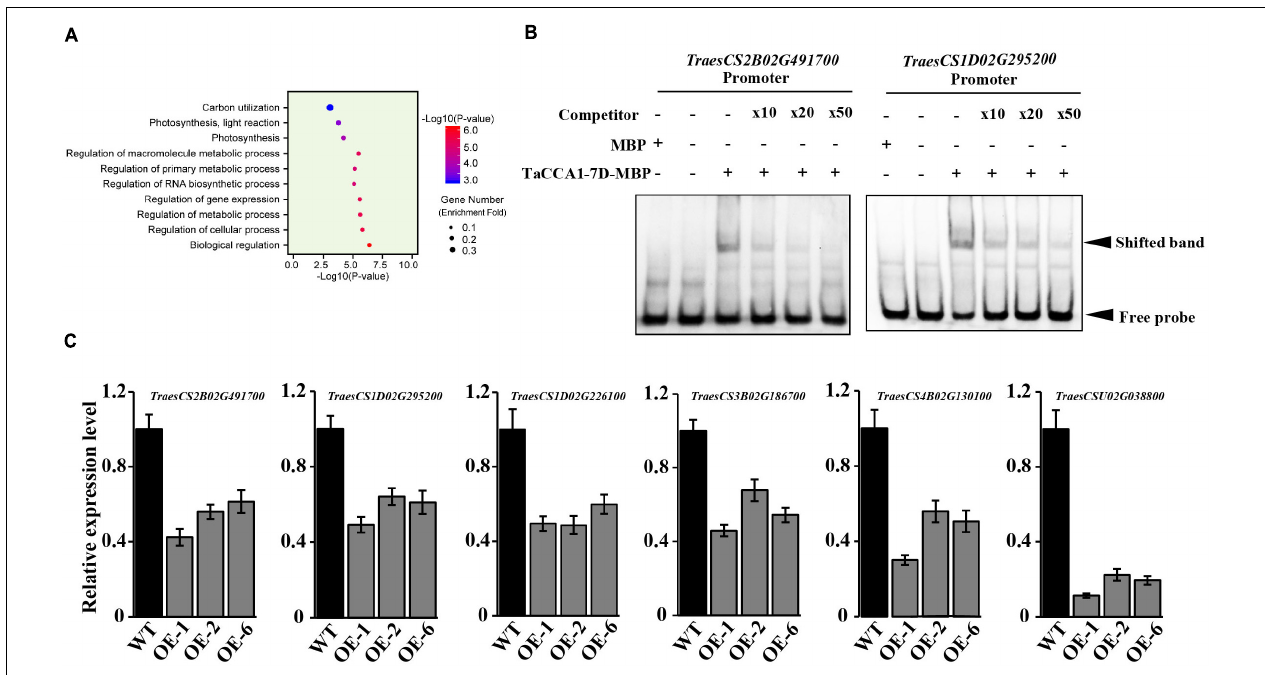
FIGURE 7 | Wheat TaCCA1 regulates genes involved in photosynthesis, energy metabolism, and auxin synthesis and transport via binding to EE-like motifs. (A) Functional enrichment analysis against GO Slim of the 15,675 putative CCA1 targets identified with a peak within 5 kb of the promoter and transcriptional start site (TSS). (B) Electrophoretic mobility shift assay (EMSA) analysis of TaCCA1-7D binding to the EE-like motif in TraesCS2B02G491700 and TraesCS1D02G295200 promoter. Lane 1, labeled probe incubated with MBP; lane 2, only labeled probe loaded; lane 3, labeled probe incubated with recombinant MBP-TaCCA1-7D; lanes 4 to 6, excessive unlabeled probe was added as a competitor with the following competitor: probe ratios: 10 (lane 4), 20 (lane 5), and 50 (lane 6). (C) qPCR analysis of relative expression levels (means ± SEM, n = 3) of EE-motif-containing genes TraesCS2B02G491700, TraesCS1D02G295200, TraesCS1D02G226100, TraesCS5D02G464800, TraesCS4B02G130100, and TraesCSU02G038800 in wild-type (Fielder), and TaCCA1-7D-OE lines grown under LD at